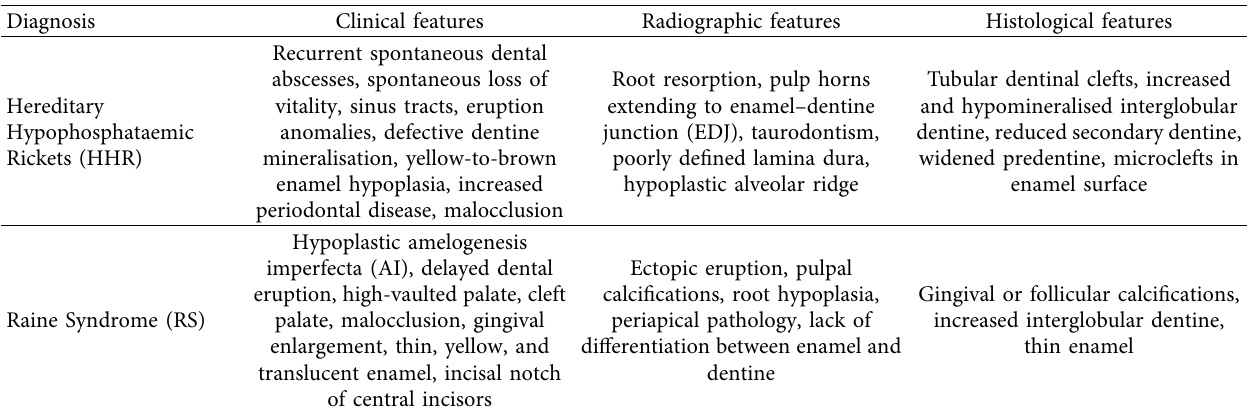
Table 2: The clinical, radiographic, and histological features of Hereditary Hypophosphataemic Rickets (HHR) and Raine Syndrome (RS) as described in the literature [2, 4–9, 11, 14, 15]. Diagnosis Clinical features Radiographic